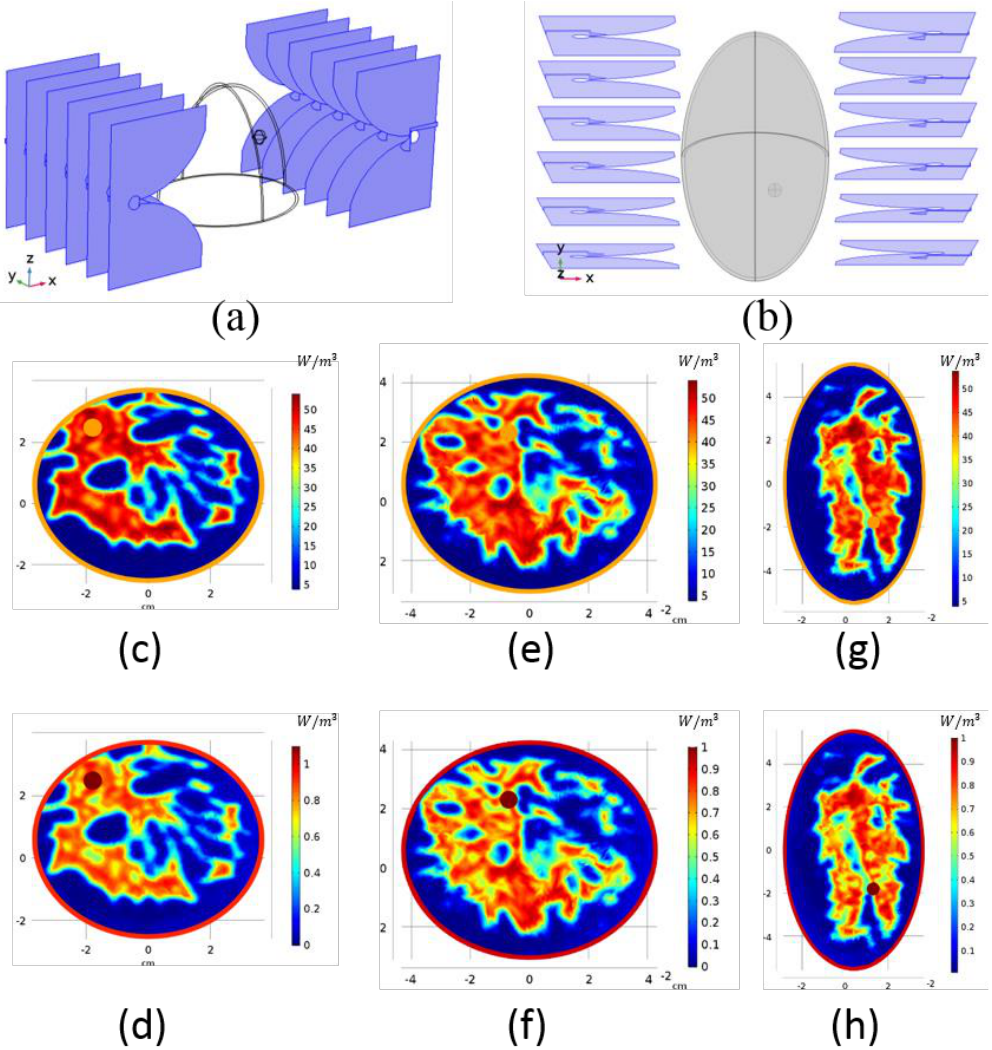
Figure 3. Simulation configuration in COMSOL environment with Vivaldi antennas and semi-ellipsoid geometries used as: ( a ) breast model-I; ( b ) breast model-II. Electrical properties of the ellipsoid shaped breast models: ( c ) relative permittivity of breast model-I at z = − 2 cm; ( d ) electrical conductivity of breast model-I at z = − 2 cm; ( e ) relative permittivity of breast model-I at z = 0 cm; ( f ) electrical conductivity of breast model-I at z = 0 cm; ( g ) relative permittivity of breast model-II at z = − 2 cm; ( h ) electrical conductivity of breast model-II at z = − 2 cm.